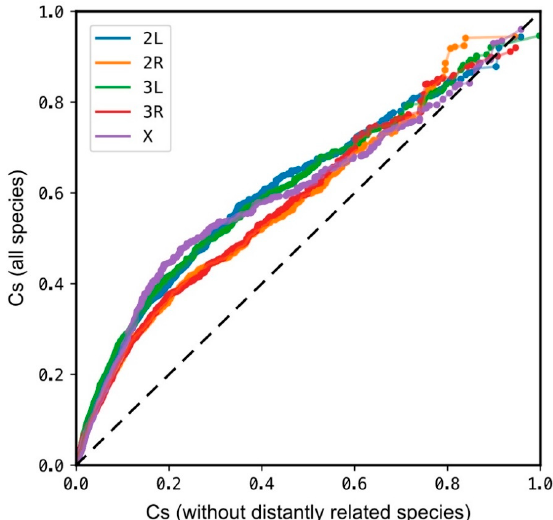
Figure A2. Q–Q plot of comparison between Cs calculated from the genome assembly data from all the species included in the analysis and Cs from a subset of genome assemblies without distantly related species. All chromosome arms show strong correlation between both groups (Pearson’s r > 0.83, p < 0.001). The inclusion of the group of more distantly related genomes skews Cs towards higher values, however, both compared groups showed similar distribution of higher scores. Plot was generated by random sampling of 10,000 genomic positions from each chromosome arm.